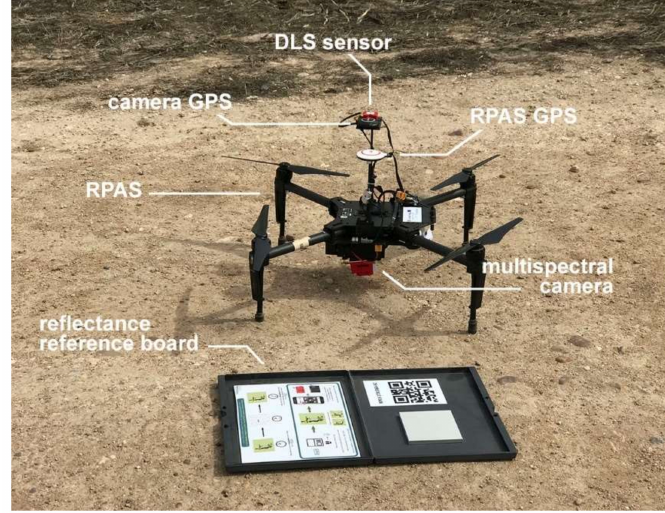
Figure 2. Equipment used to capture the aerial imagery used in this